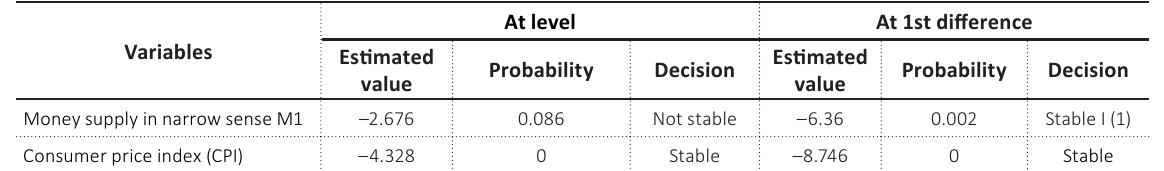
Table 3. ADF results for